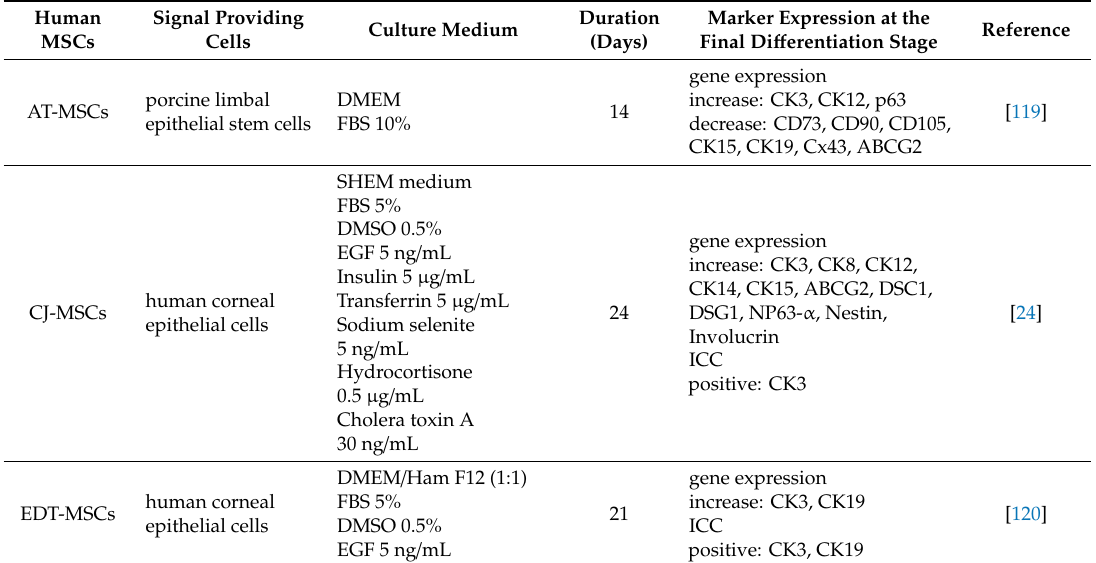
Table 1. Corneal epithelial di ff erentiation of human MSCs in the co-culture